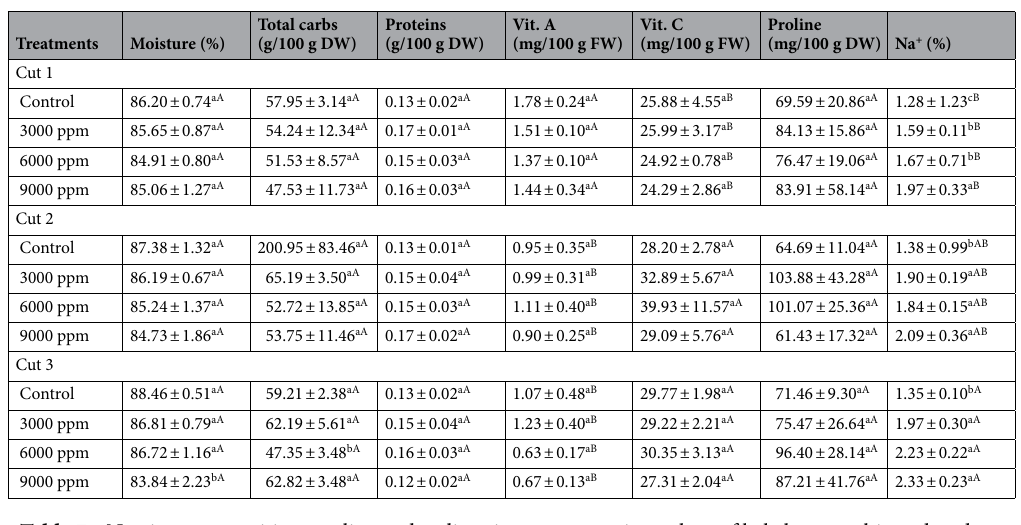
Table 7. Nutrient composition, proline and sodium ion concentration values of kale leaves cultivated under freshwater and different salinities (3000 ppm, 6000 ppm, and 9000 ppm) at different cutting time points. Data expressed as mean ± SD (n = 3). Different lower superscript letters within the same column at the same cutting time point indicate a significant difference within the treatments at p < 0.05. Different upper superscript letters within the same column indicate a significant difference between the cuts at p < 0.05.